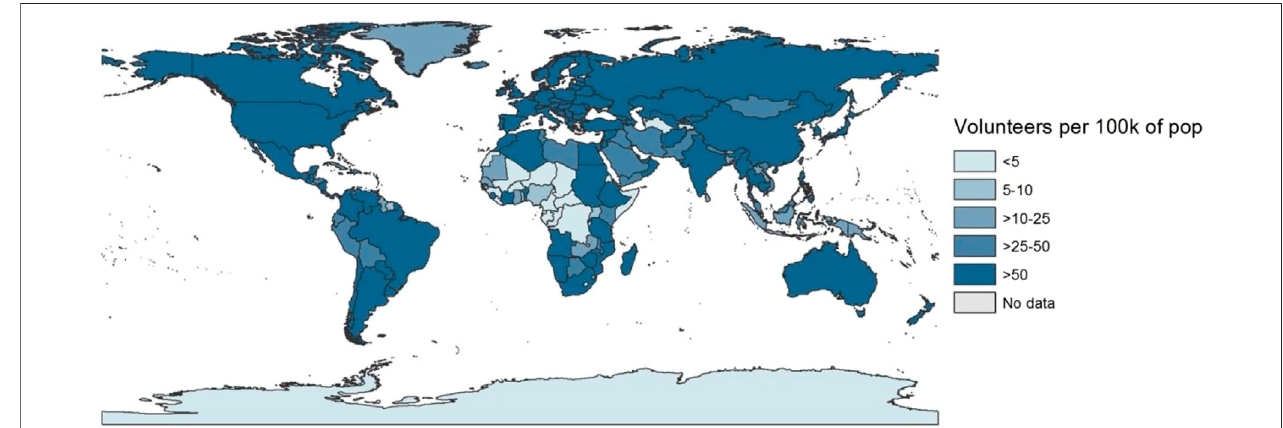
FIGURE 1 | Spatial distribution of citizen scientists divided by